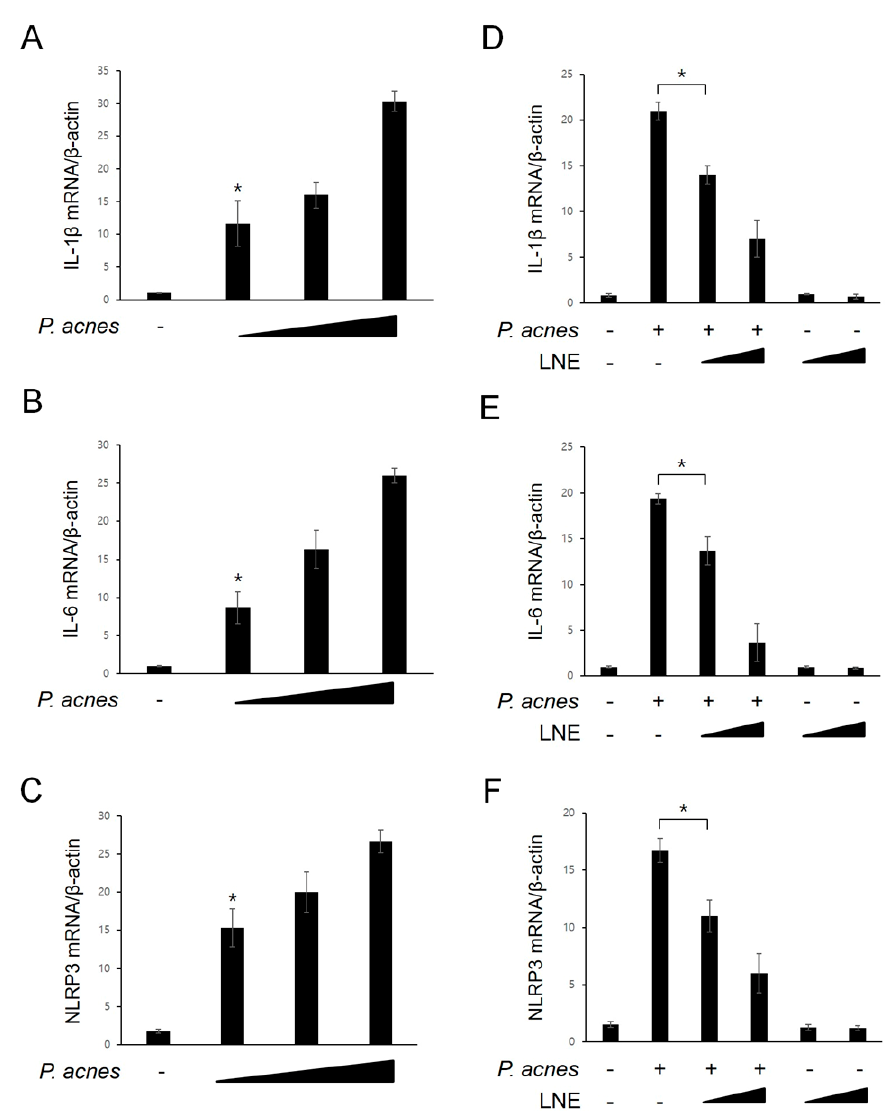
Figure 2. LNE inhibits P. acnes -induced proinflammatory cytokine expression. ( A – C ) BMMs were treated with increasing concentrations of P. acnes (1 × 10 5 , 1 × 10 6 and 1 × 10 7 CFU) for 6 h, and the mRNA (IL-1 β , IL-6 and NLRP3) levels were analyzed using quantitative real-time PCR. ( D , E ) Cells were treated with LNE (25 and 50 μ g/mL) for 30 min before P. acnes stimulation (1 × 10 7 CFU) for 6 h. The mRNA (IL-1 β , IL-6, and NLRP3) levels were analyzed using quantitative real-time PCR. * p < 0.05.